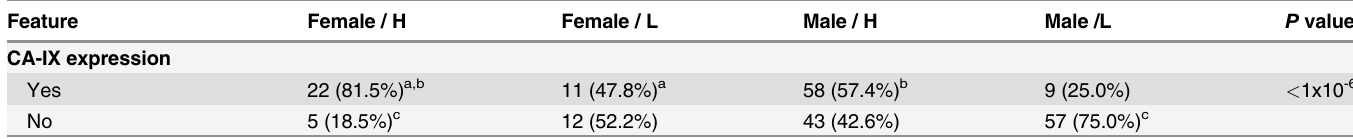
Table 3. Analysis of CA-IX protein expression in 227 patients with surgically resectable primary hepatocellular carcinoma strati fi ed by gender and tumor stage